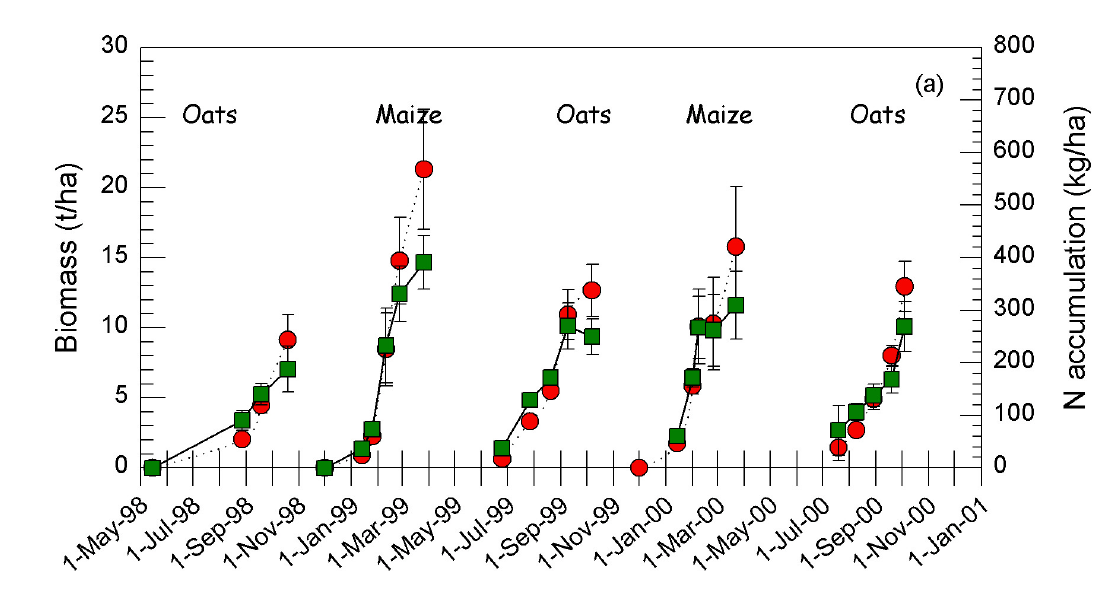
FIGURE 2. Averaged biomass ( (cid:1) ) and total N ( (cid:3) ) accumulation in the tops of the oats and maize. Vertical bars represent the standard error ( p = 0.05) of the mean at each sampling